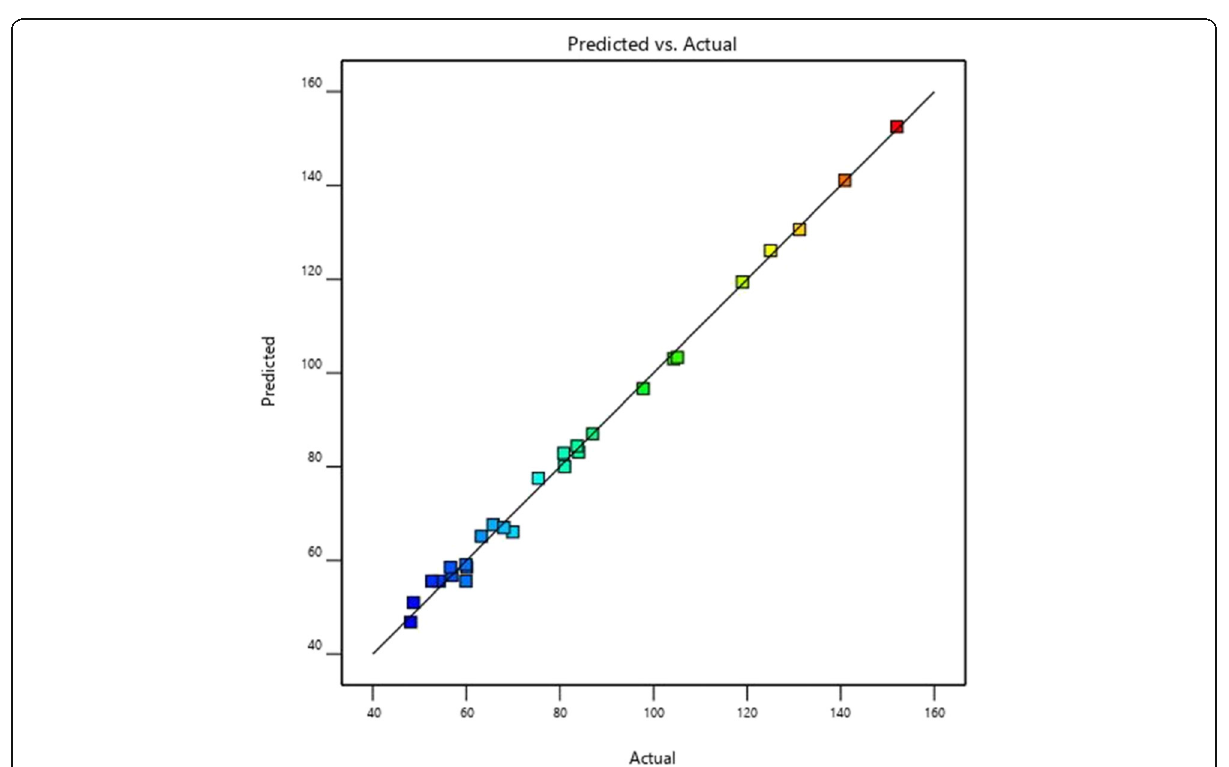
Fig. 9 Residual plots for the xylanase activity of the xylanolytic bacterial strain Pseudomonas mohnii calculated from RSM for the validation of predicted and actual xylanase